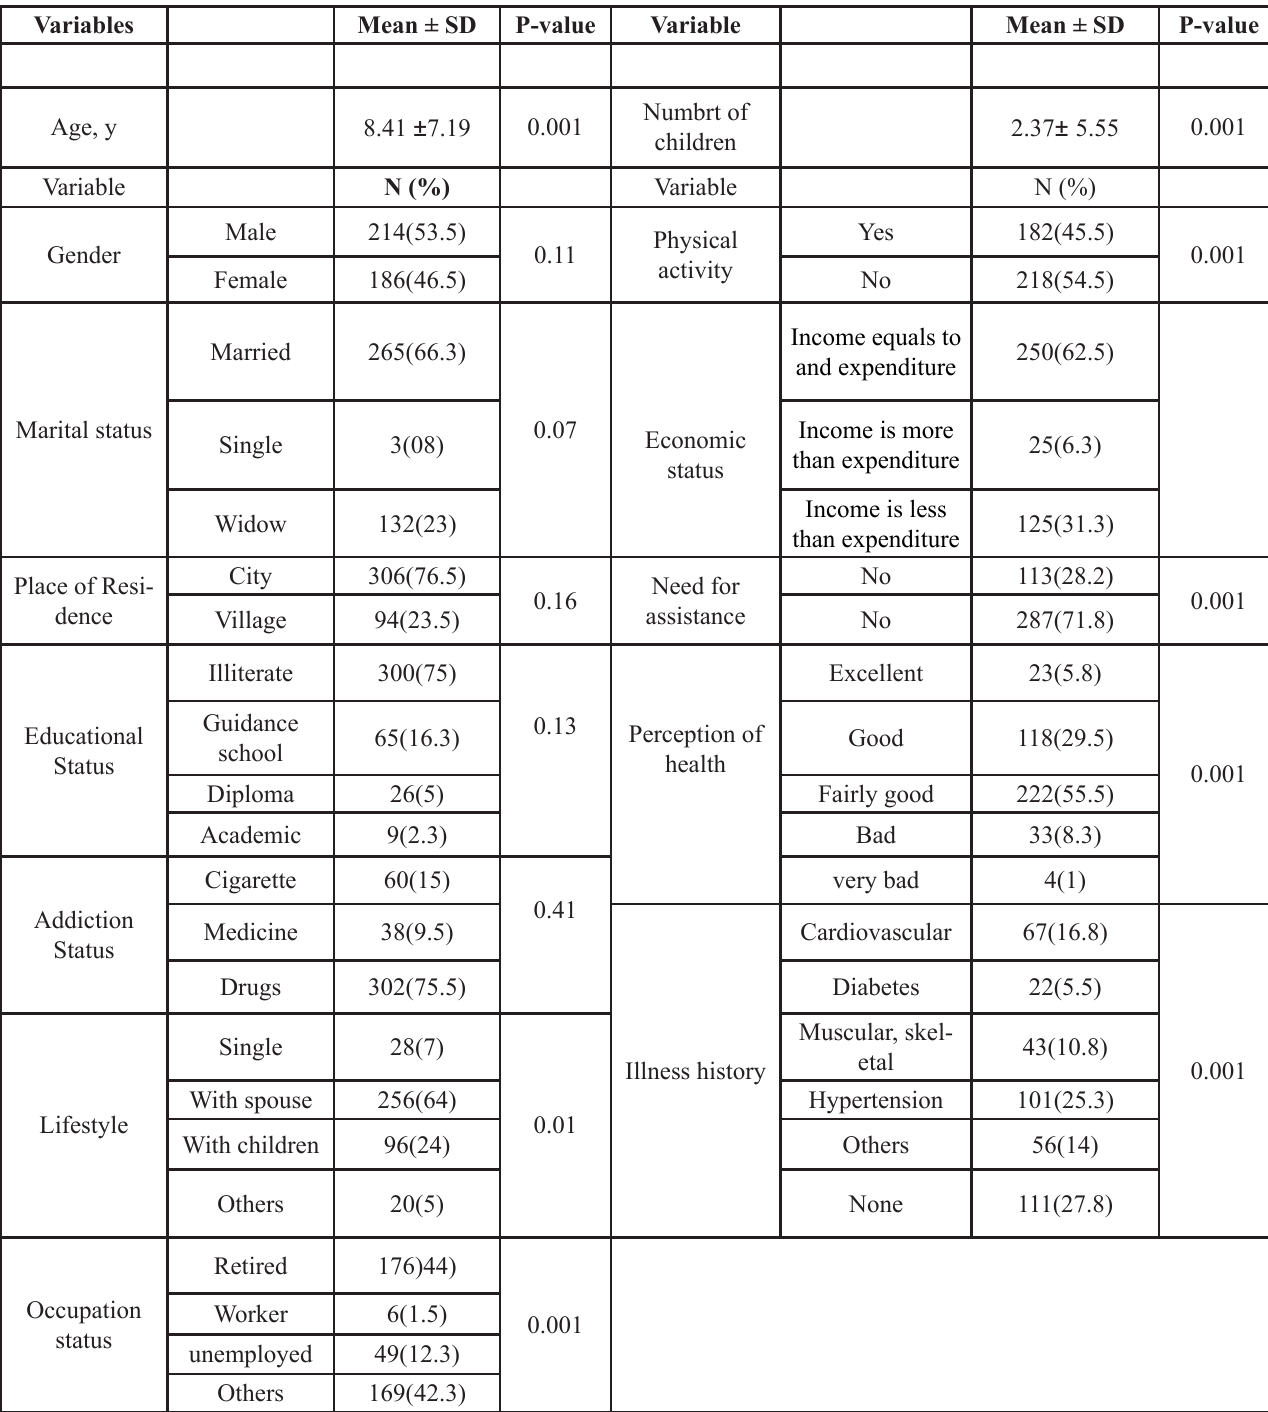
Table 1. Demographic characteristics and their relationship with disability